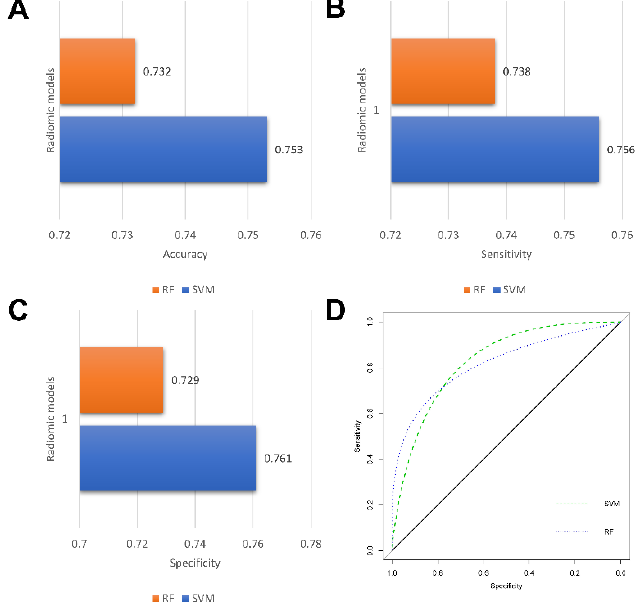
Figure 6. Performance of radiomics models. Bar charts of accuracy ( A ), sensitivity ( B ), and specificity ( C ); Receiver operating characteristic (ROC) curves of radiomics models ( D ).